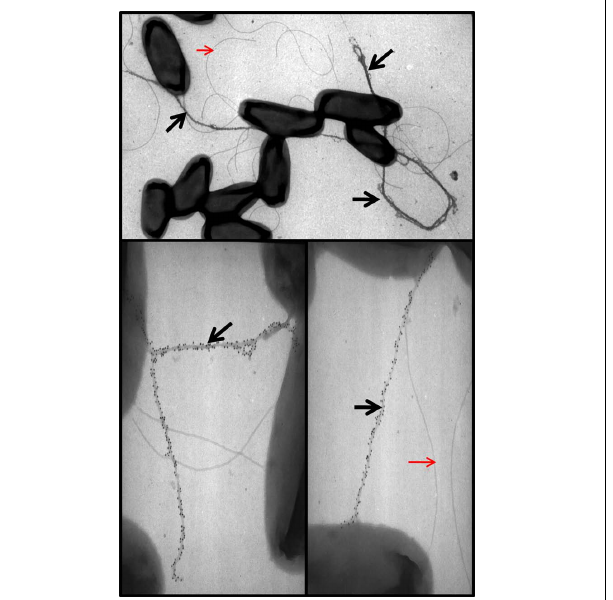
FIGURE 6 | XcpT pseudopilin overexpression results in pseudopilus formation. Shown are the results ofTEM analysis of P. aeruginosa PAO1 overexpressing xcpT from pMTWT as described in Durand et al. (2003).The pseudopili are indicated with a black arrow and are labeled with gold particles coupled to antibodies against XcpT. Red arrows indicate unlabeled flagella for